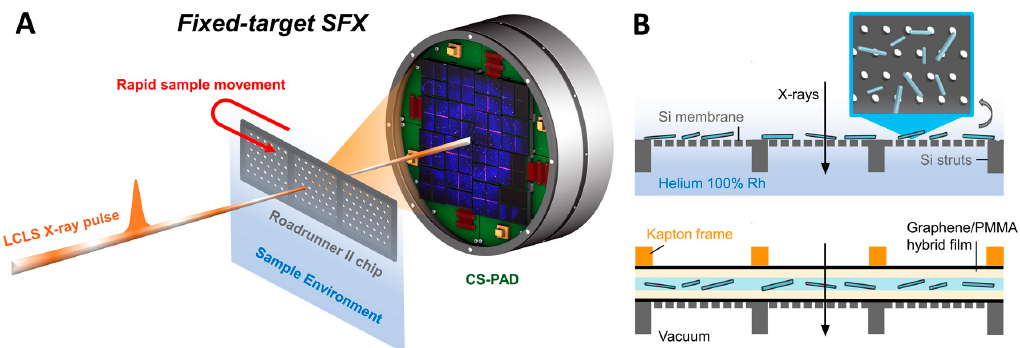
Figure 1. Scheme illustrating ( A ) serial femtosecond crystallography (SFX) data collection and the